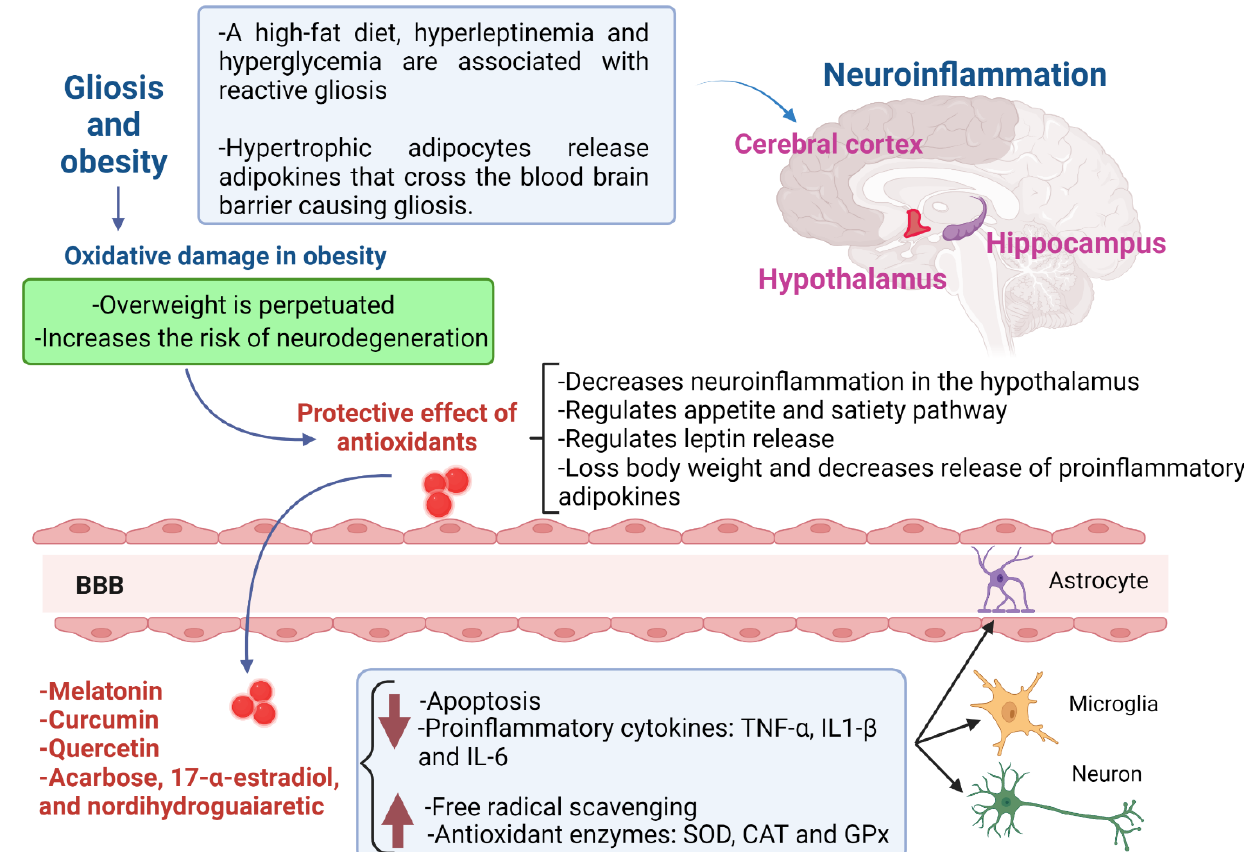
Figure 1. Gliosis in obese patients and the protective role of antioxidants in neuroinflammation. The gliosis is promoted by a high-fat diet, leptin and hyperglycemia in obese patients; this provokes neuroinflammation, mainly in the hypothalamus, which perpetuates overweight, because the satiety-appetite signaling is disrupted. The most promising candidates for the treatment of gliosis in obese patients are melatonin, curcumin, quercetin, acarbose, 17- α -estradiol and nordihydroguaiaretic. Two main antioxidant mechanisms exert neuroprotection: a decrease in apoptosis, leptin release and proinflammatory cytokines, and an increase in free radical scavenging and antioxidant enzymes. The cells that are protected by antioxidants could be the astrocytes, microglia and neurons. BBB, blood –brain barrier; TNFα, tumor necrosis factor alpha; IL - 1β, interleukin 1β; IL -6, interleukin-